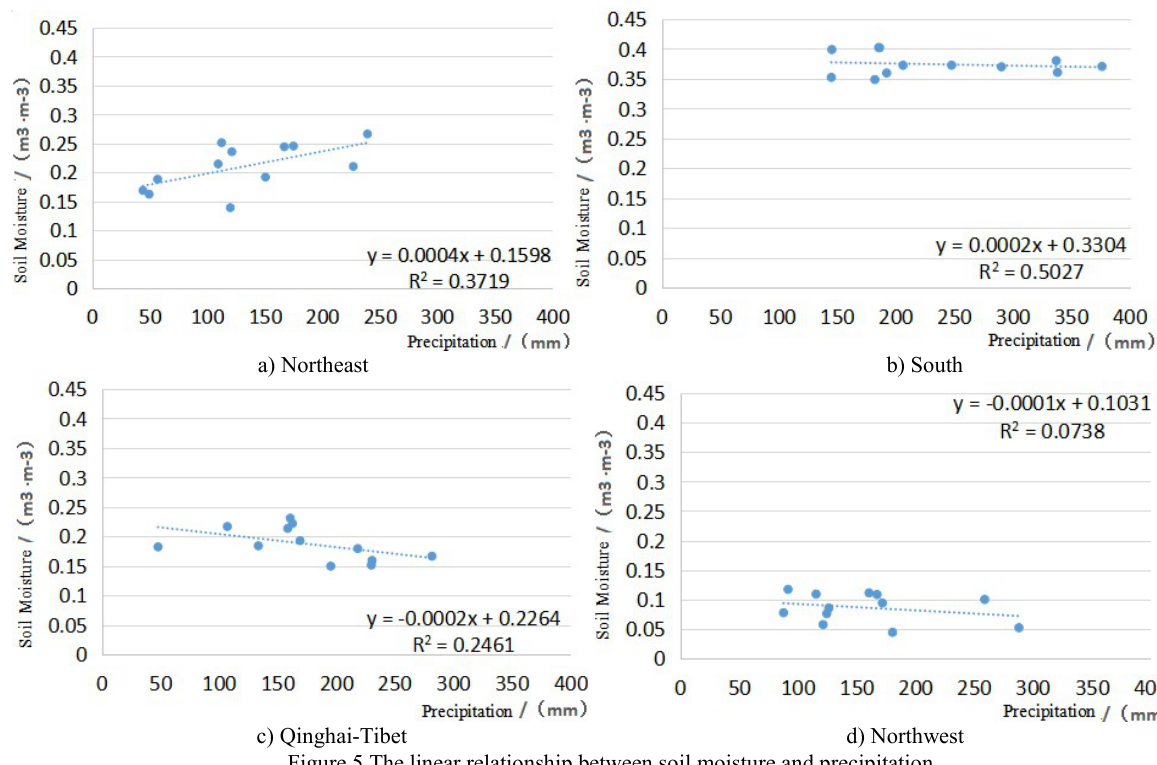
Figure 5 The linear relationship between soil moisture and